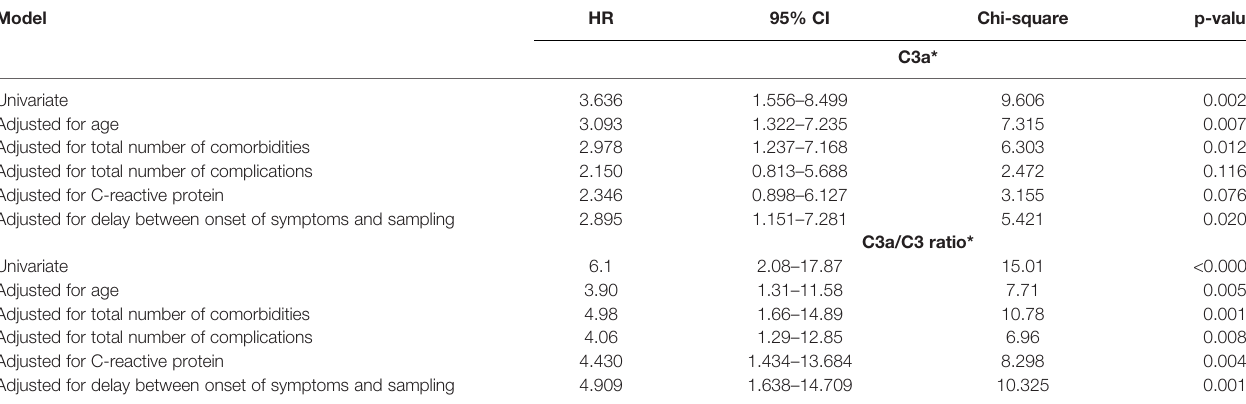
TABLE 4 | Results of univariate and multivariable Cox proportional-hazards regression models analyzing effects of complement overactivation in-hospital mortality. Model